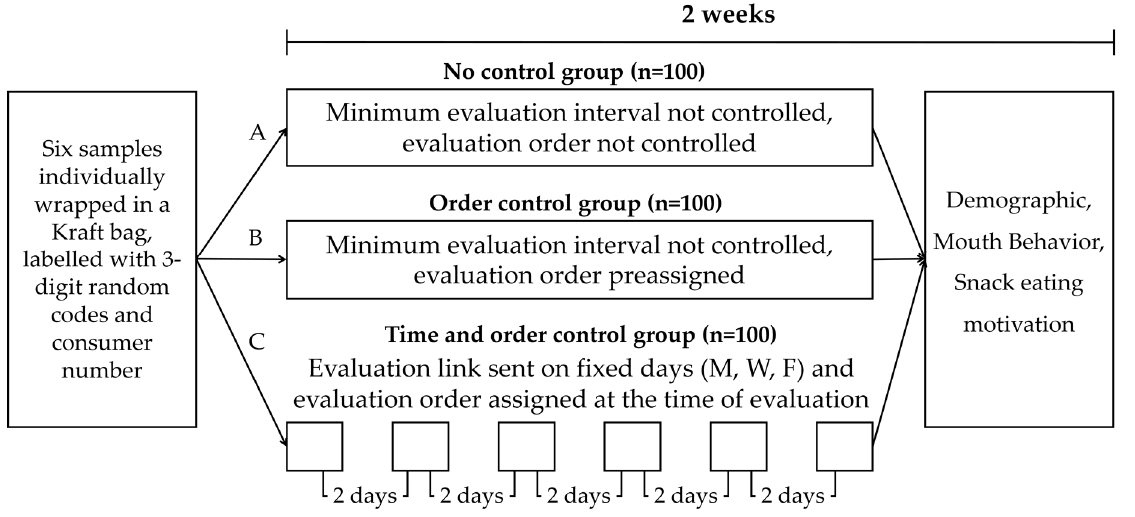
Figure 2. Schematic diagram of test design for comparing three home use tests with differing test controls.